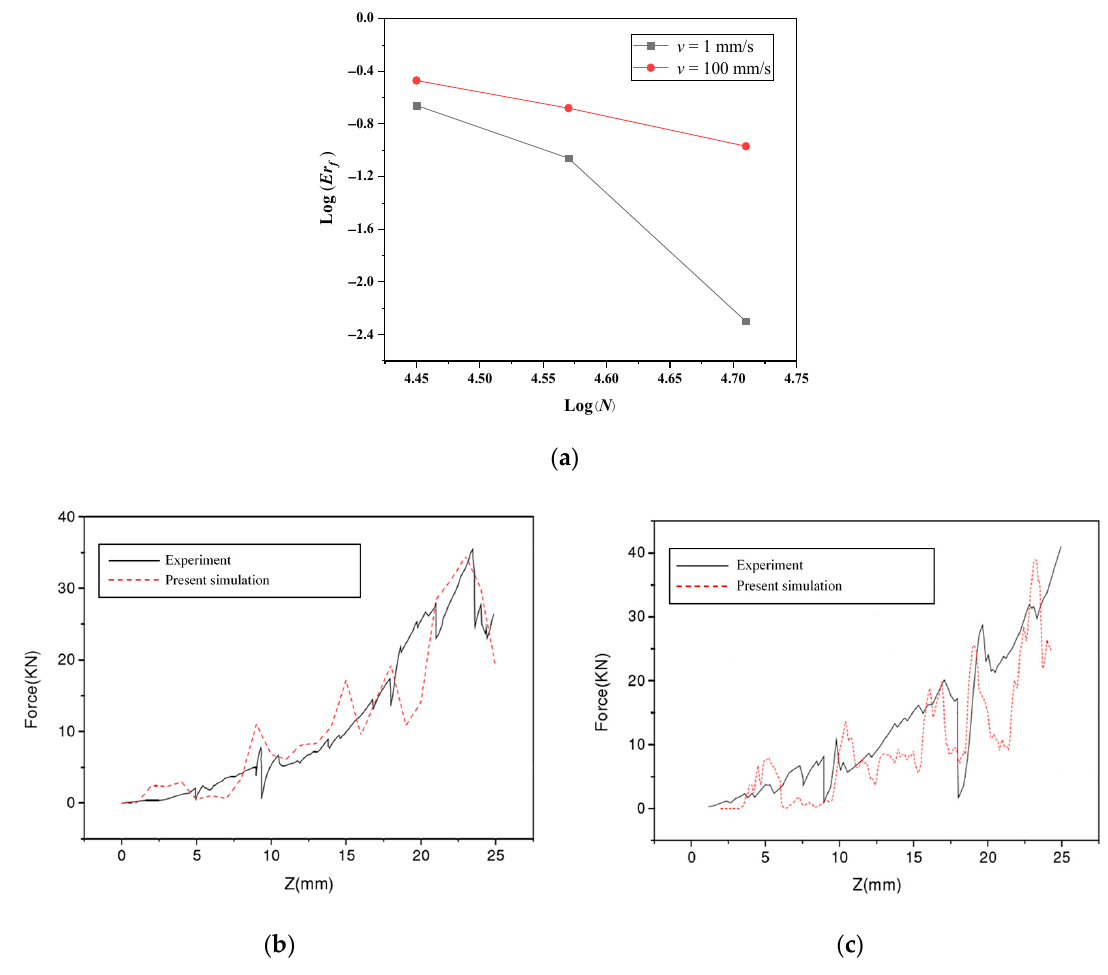
Figure 2. Convergence tests of force by different compression speed ( a ), and comparisons of the force-displacement curves at different compression speed ( b ) v = 1 mm/s and ( c ) v = 100 mm/s.